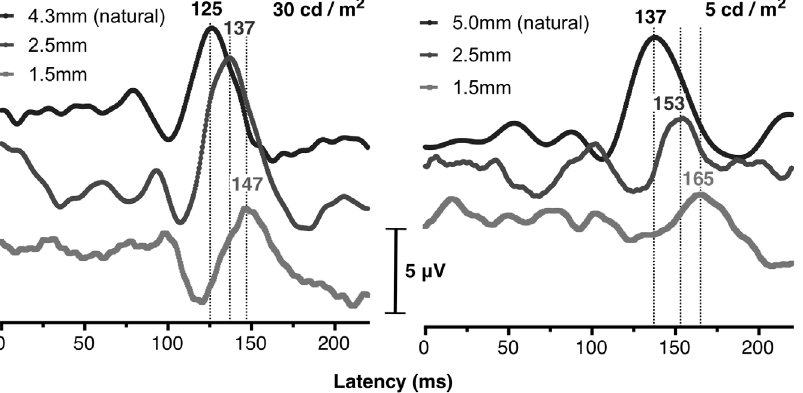
Figure 1. Effect of CL aperture luminance levels on a characteristic VEP waveform. Grand-averaged (64 epochs) monocular VEP waveforms from one subject at high (30 cd/m 2 , left) and low (5 cd/m 2 , right) photopic levels for a natural pupil (black line) and with a contact lens of 2.5 mm (dark grey line) and 1.5 mm (light grey line) aperture. P100 latency is indicated in ms.